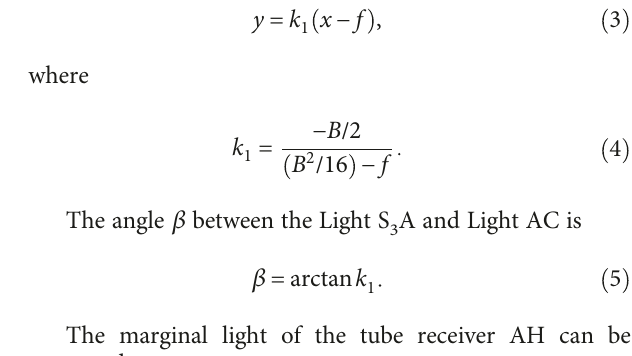
=12 mm and α =0.05 ° ; (c) L el =19mm and α =0.2 ° el